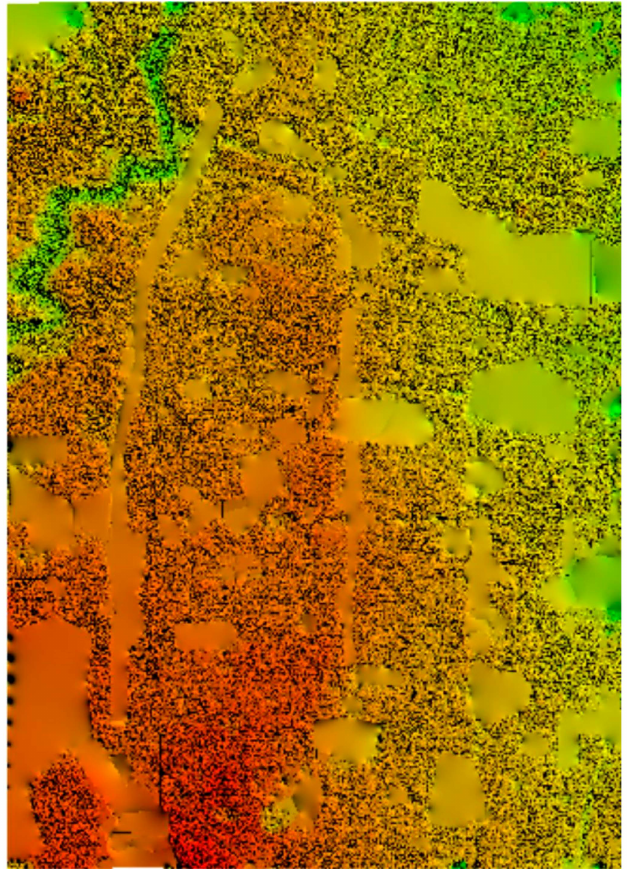
Figure 18. DEM Product After Positioning and